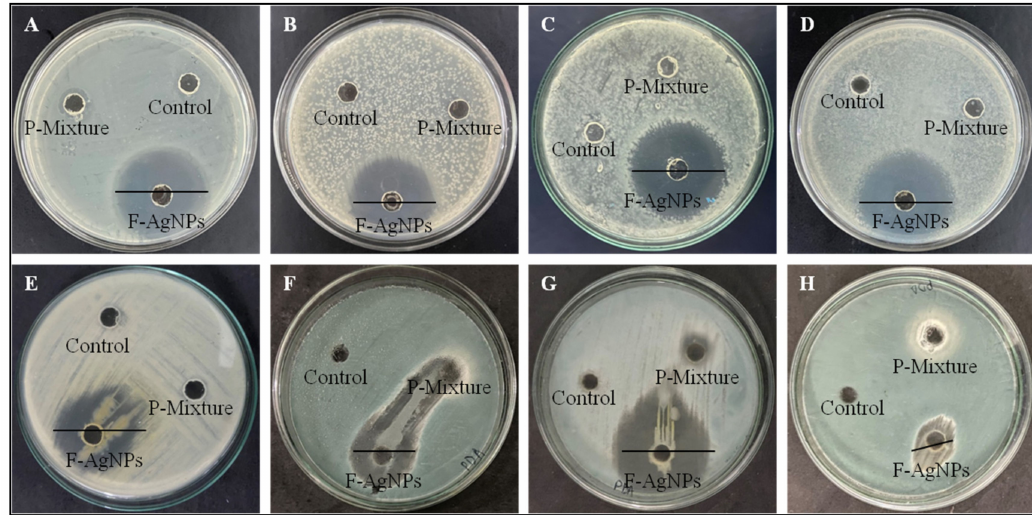
Figure 2. Images showing the antibacterial zones of inhibition of F-AgNPs and the fungus isolated protein mixture (P- mixture) against ( A ) MDR Staphylococcus aureus , ( B ) Klebsiella pneumonia , ( C ) Salmonella abony, ( D ) MDR Escherichia coli bacteria and antifungal zone of inhibition against ( E ) Aspergillus flavus , ( F ) Aspergillus niger , ( G ) Trichoderma viridens , and ( H ) Fusoriumoxyporium fungus. Milli-Q water was used as a